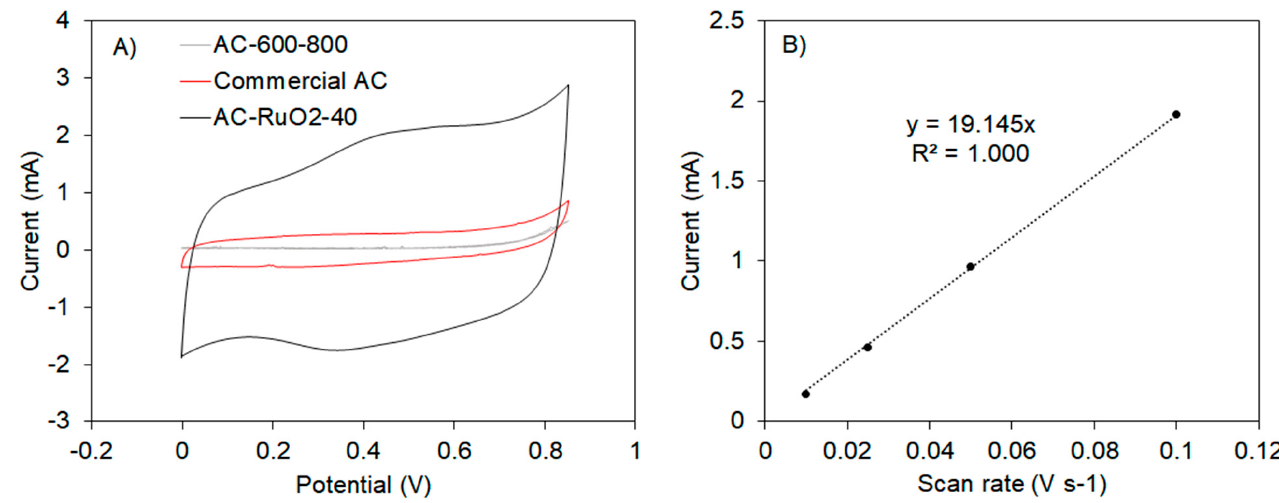
Figure 10. ( A ) CV of electrodes made of primed current collector and three different active materials. Electrolyte: 0.5 M H 2 SO 4 , Scan rate: 100 mV s − 1 . ( B ) Behavior of the current obtained at 0.4 V during the CV of AC-RuO 2 -40 at different scan rates. AC-600-800.